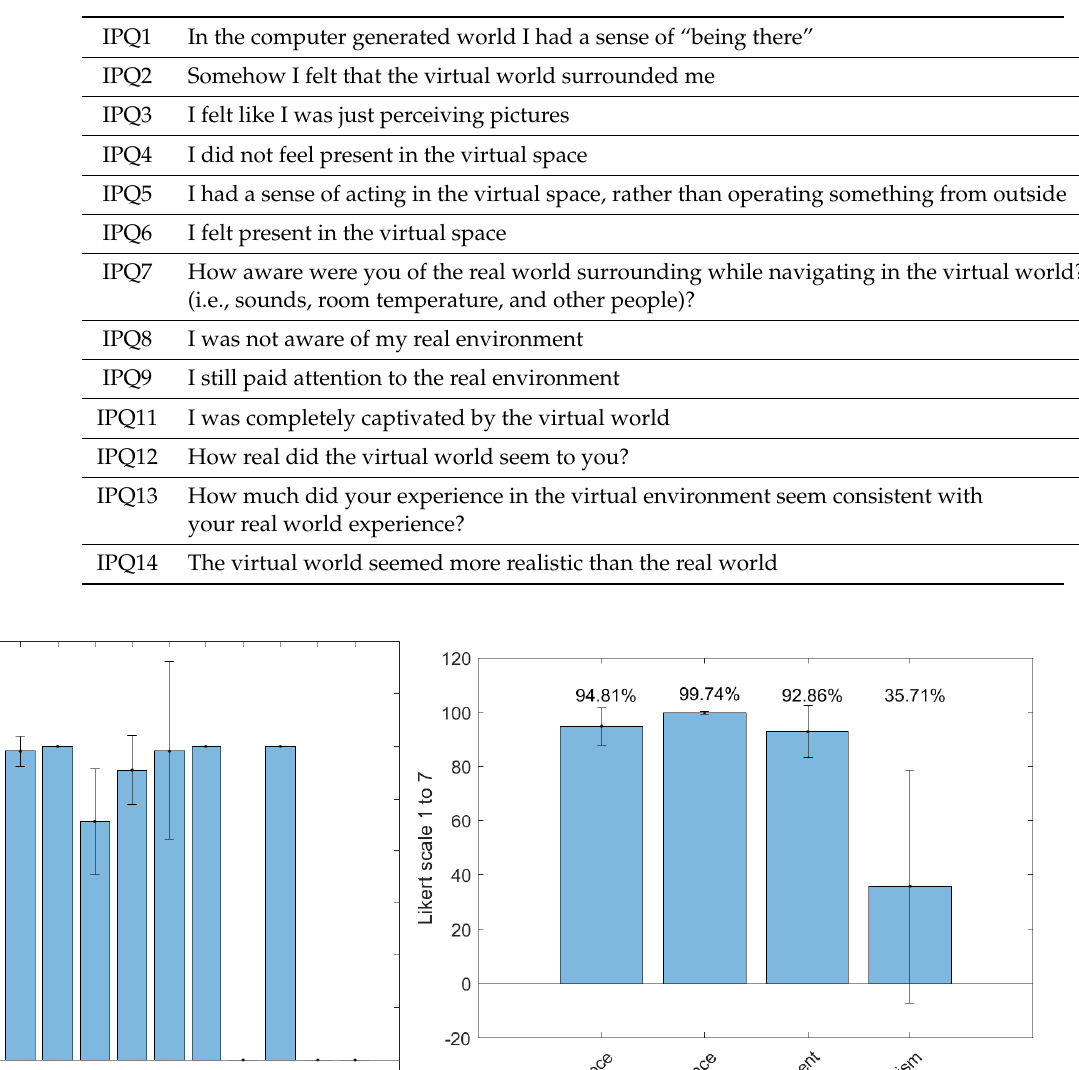
Table 2. Questions of the IPQ questionnaire [77–79].